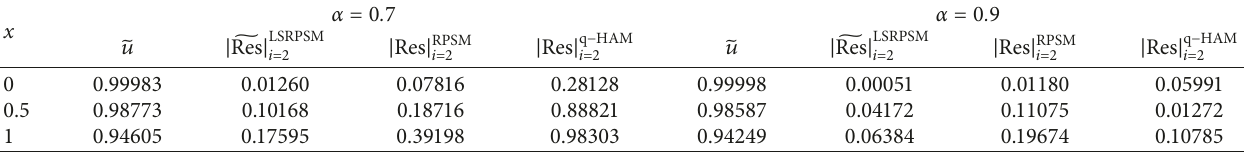
Table 4: The values of | 􏽦 Res ( x,t )| by LSRPSM, RPSM, and q-HAM for α � 0 . 7 , 0 . 9 and t � 0 .